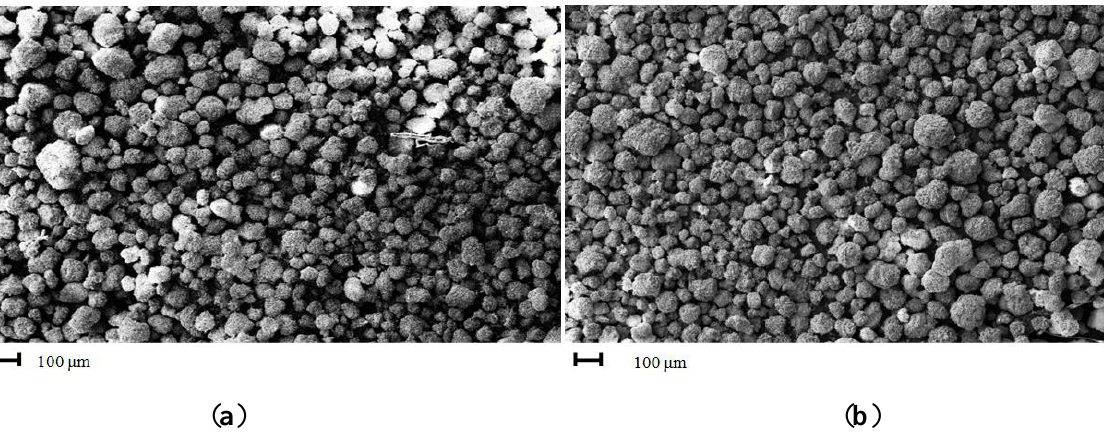
Figure 1. Scanning Electron Micrographs (SEM) image of Ni-P plated for ( a ) 2 min; ( b ) 10 min.